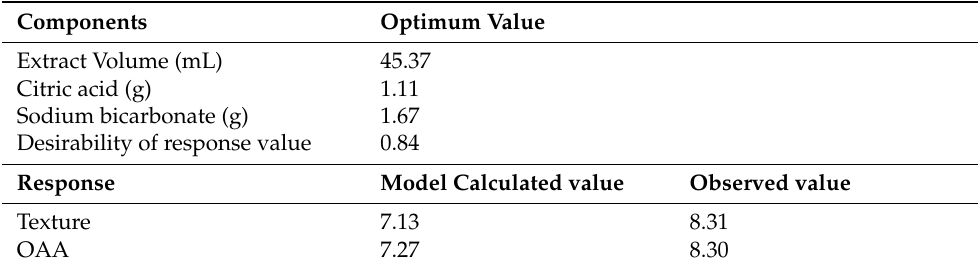
Table 4. The optimization and outcome of the optimized